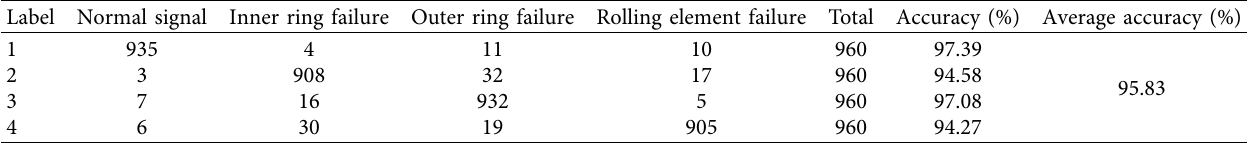
Figure 12: Time domain waveforms of bearing vibration signals in different states: (a) normal signal, (b) inner ring failure, (c) outer ring failure, and (d) rolling element failure. Table 3: Experimental results.